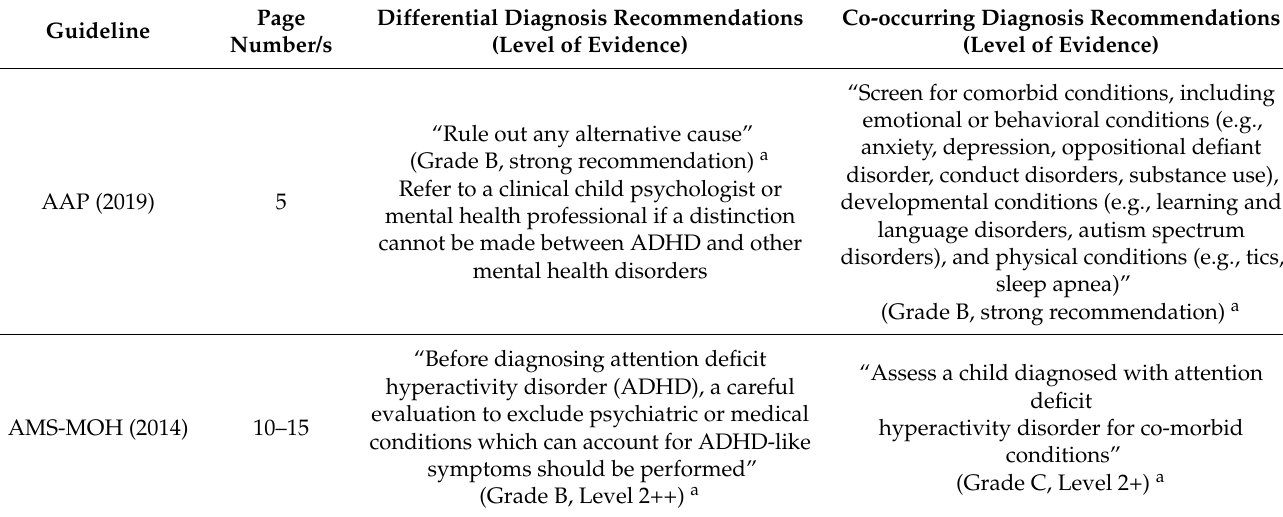
Table 5. Recommendations for differential and co-occurring diagnosis in each